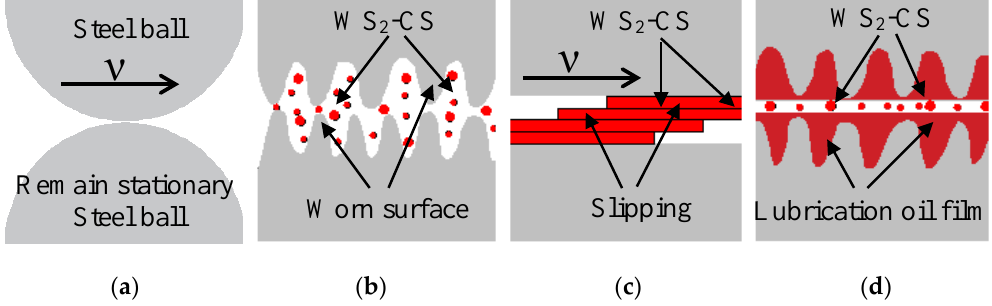
Figure 13. Lubricating mechanism diagram: ( a ) relative movement of the pair; ( b ) distribution and dispersion of the nano-materials; ( c ) interlaminar slide of the nano-sheets; ( d ) formation of the self-repairing film.